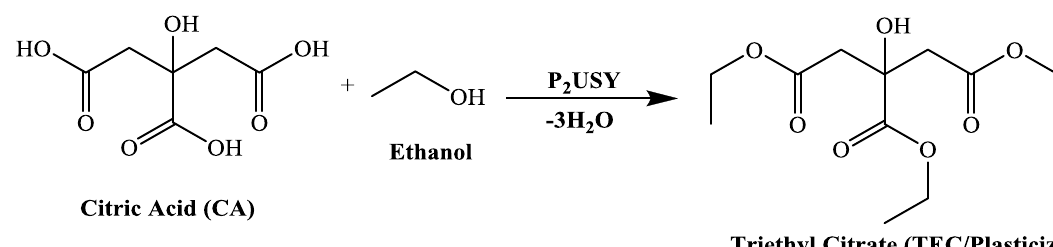
Figure 11. Esterification reaction of citric acid with ethanol over P 2 USY zeolite [122] .